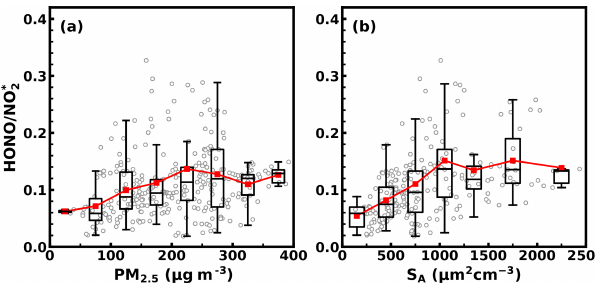
Figure 3. Box plots displaying the variation of HONO / NO ∗ (a) PM 2 . 5 concentration and (b) ambient aerosol surface area den- sity. Red markers are the mean values of HONO / NO ∗ give the HONO / NO ∗ range from the 25th to the 75th percentile, 2 and bars give the range from the 5th to the 95th percentile; the black lines in the boxes are the